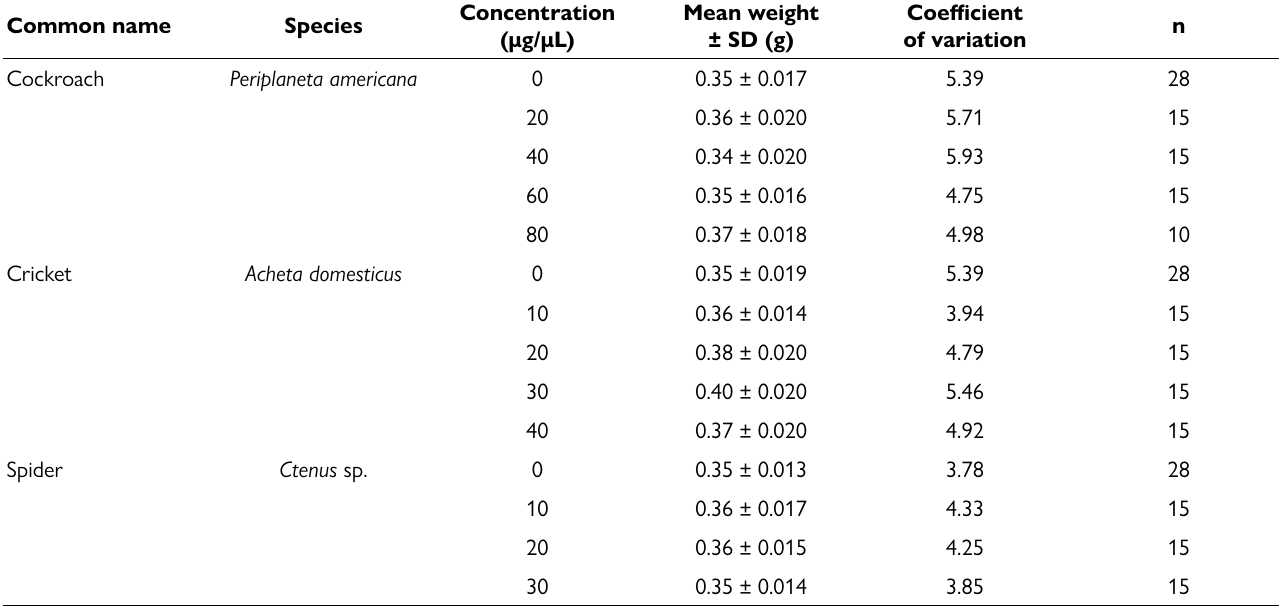
experiments. Used prey were: cockroaches ( Periplaneta americana ), crickets ( Acheta 50